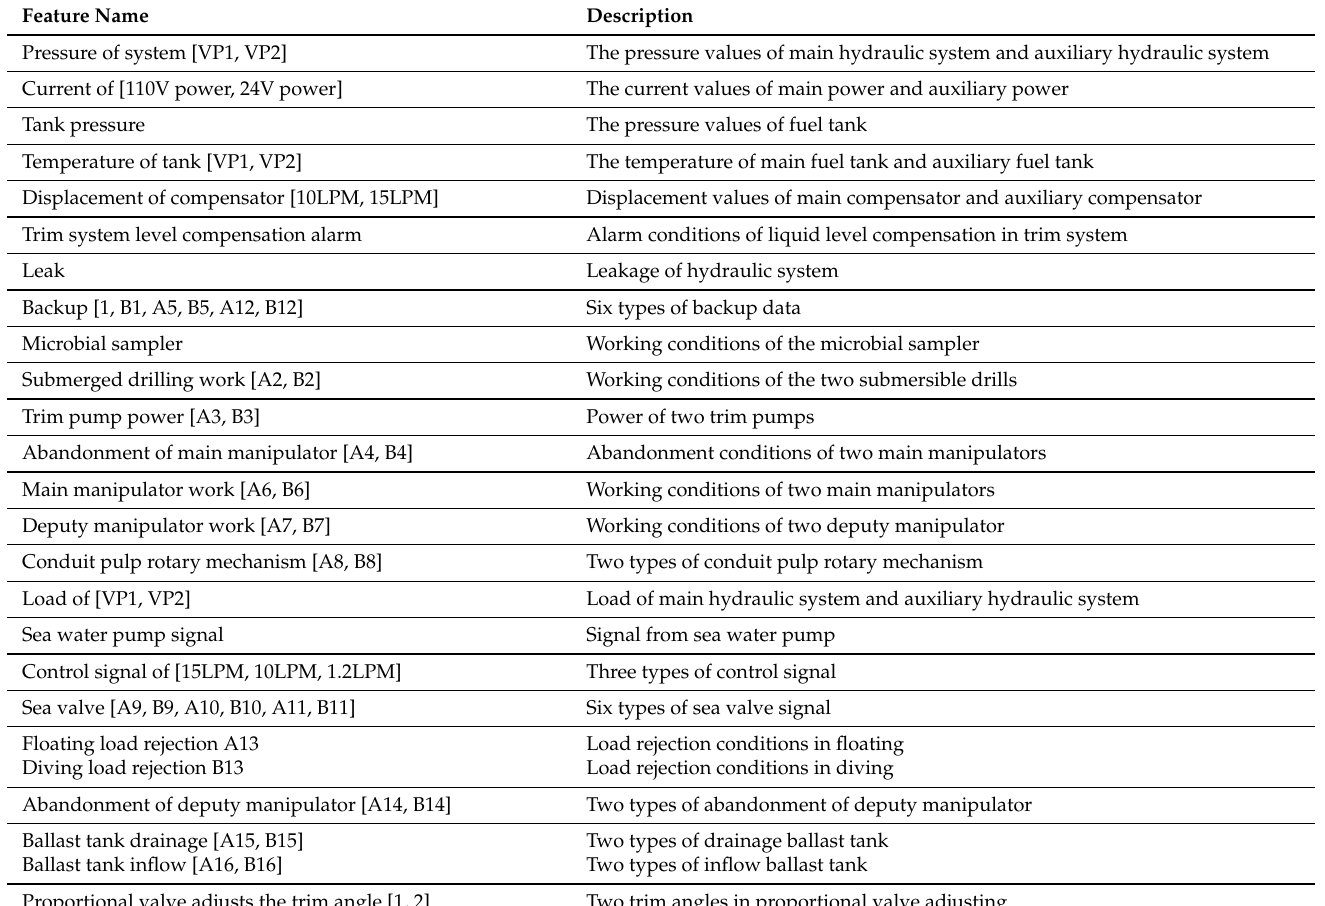
Figure 1. Structural sketch and corresponding sensing signals of Jiaolong submersible: ( a ) structural sketch of Jiaolong submersible; ( b ) sensing signals of Jiaolong submersible. Table 2. The features of hydraulic